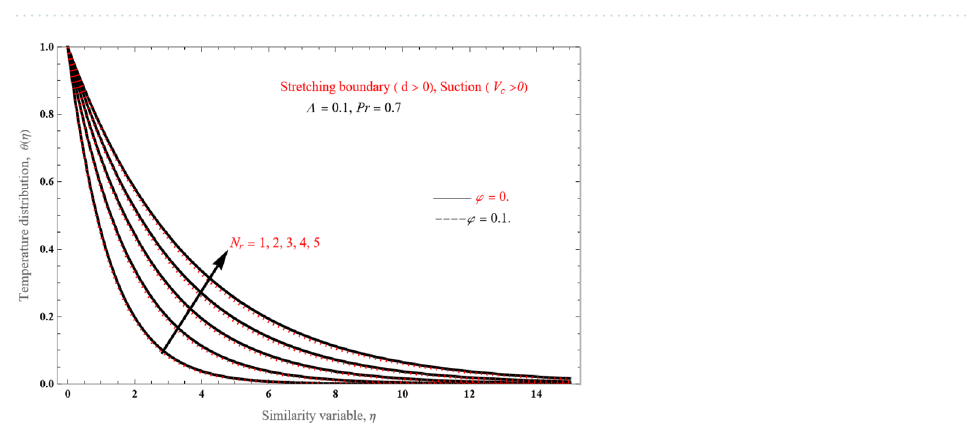
Figure 13. Temperature profiles for various values of the radiation parameter N r